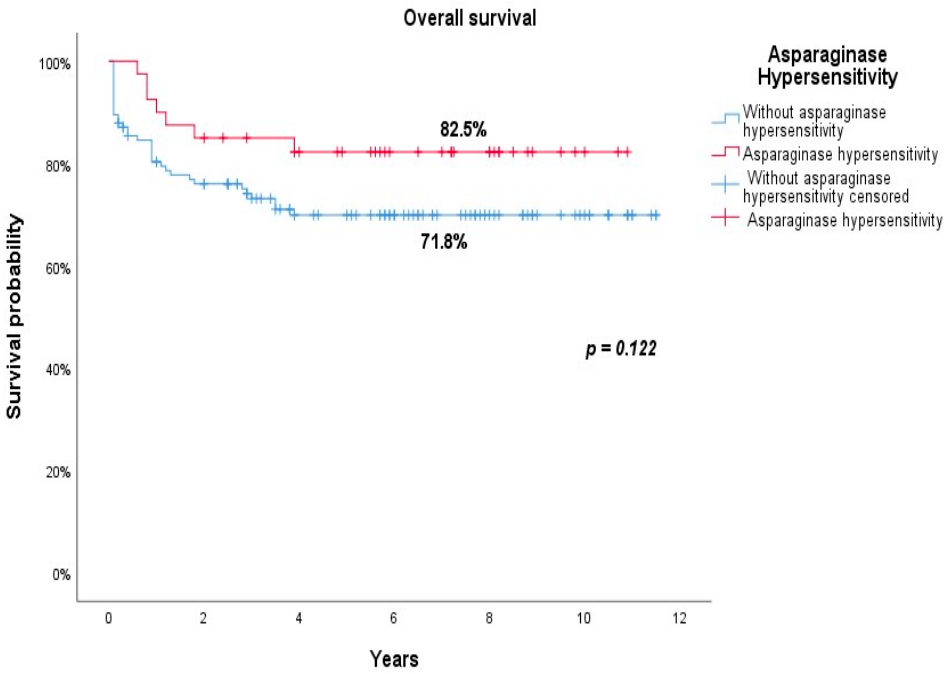
Figure 2. Overall survival of patients with (red line) and without (blue line) clinical hypersensitivity.